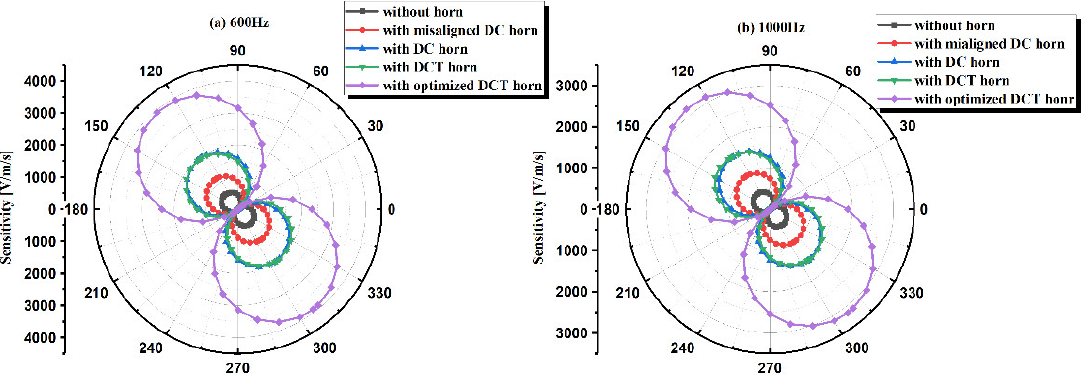
Figure 14. Directivity of TAPVS with and without acoustic horns at: ( a ) 600Hz and ( b ) 1000 Hz.